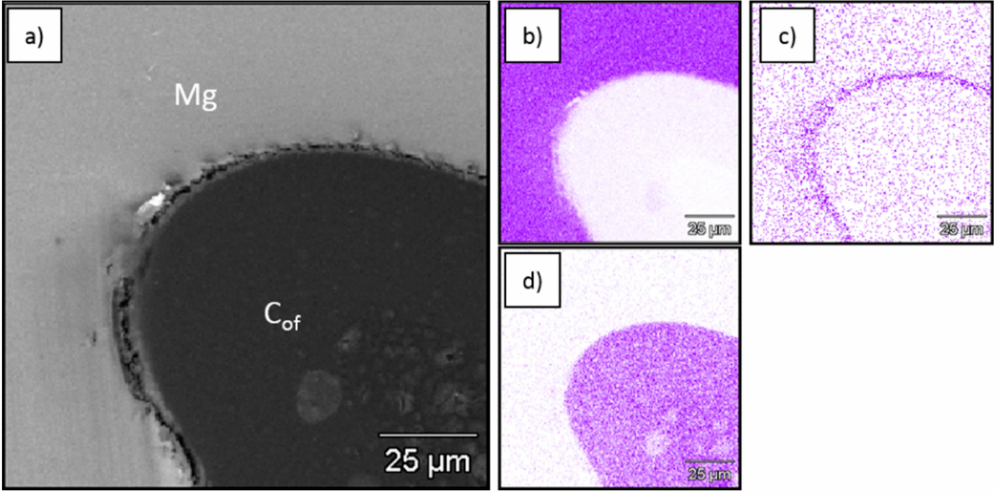
Figure 2. SEM micrograph of C of 20ppi–Mg composite ( a ) and EDS mapping of ( b ) Mg, ( c ) O and ( d ) C.